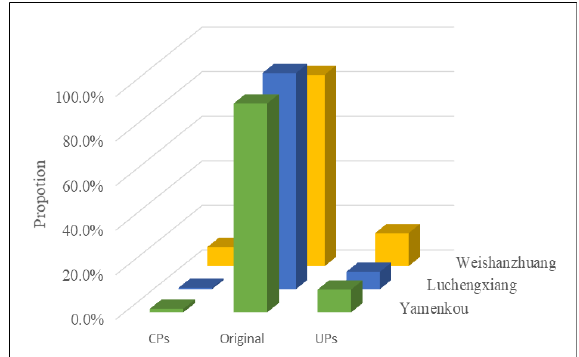
Figure 12. Proportion (%) of different samples before and after HUP detachment.